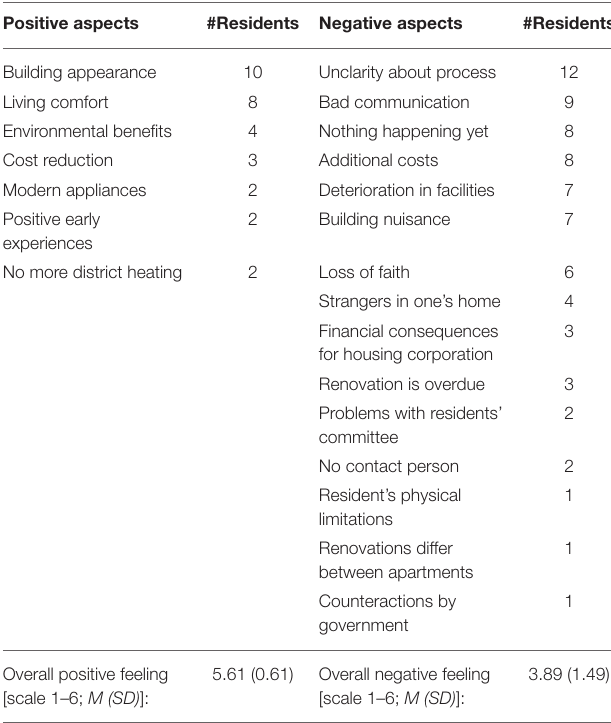
TABLE 1 | Positive and negative aspects of the sustainable renovation of the apartment